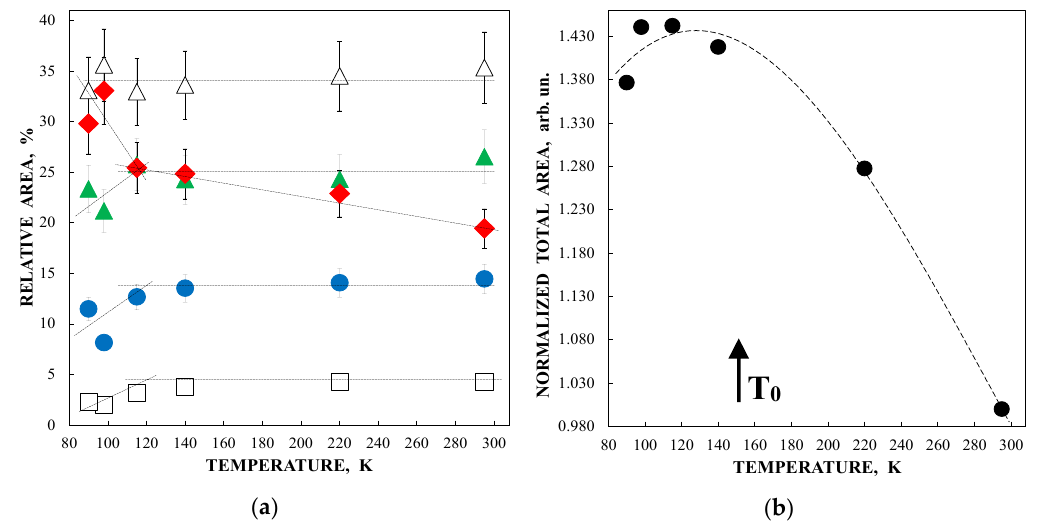
Figure 8. Temperature dependencies of: ( a ) the relative areas for components 1–5 revealed in the ferritin Mössbauer spectra ( ♦ is component 1, △ is component 2, ▲ is component 3, • is component 4 and □ is component 5; dashed lines indicate different slopes above and below critical temperature) and ( b ) normalized total spectrum areas ( • , dashed line indicates polynomial approximation, arrow indicates critical temperature T 0 ). Adapted from Ref. [49] with permission from Elsevier: Spectrochim‑